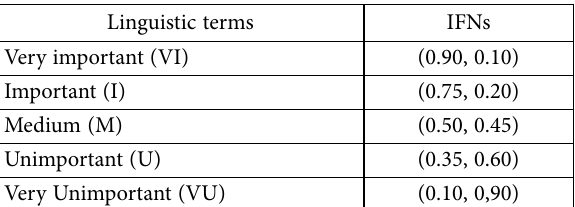
Table 3. Linguistic terms for criteria and the DMs weight